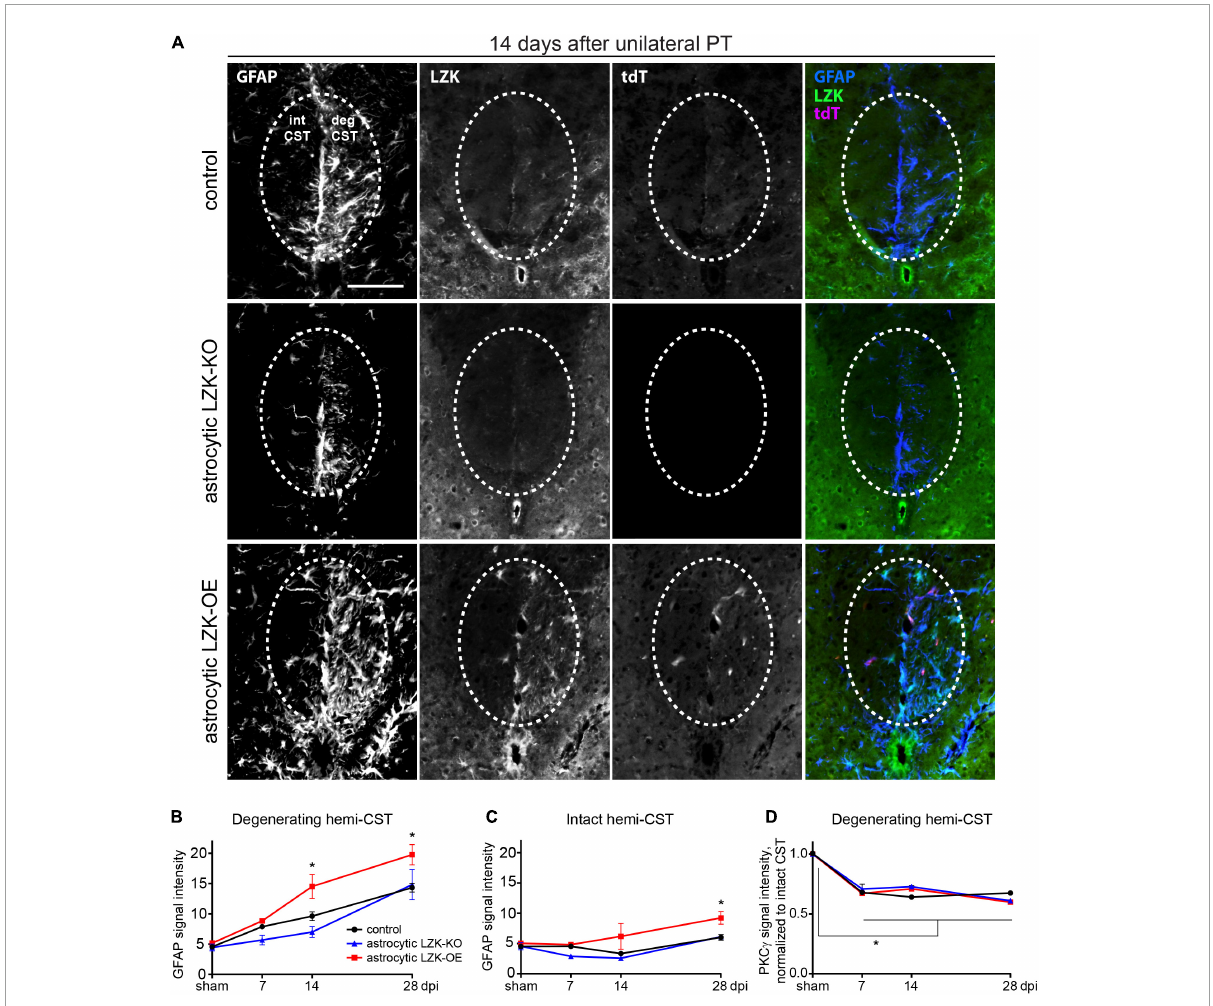
FIGURE2 LZK is a positive regulator of astrocyte reactivity to CST axon degeneration. (A) Immunofluorescence staining of LZK and GFAP in the CST at the cervical spinal cords of tamoxifen treated genotype control, astrocytic LZK-KO (GFAP-CreER T2 ; LZK f / f ), and astrocytic LZK-OE (GFAP-CreER T2 ; LZK OE ) mice; 14 days after unilateral PT. Dotted ovals outline the CST; intact and degenerating (deg) hemi-CSTs are indicated in the upper left panel that applies to all images; scale bar represents 100 µ m. (B) Quantification of astrocyte reactivity within the degenerating hemi-CST, based on GFAP immunofluorescence intensity, in tamoxifen treated genotype control, astrocytic LZK-KO (GFAP-CreER T2 ; LZK f / f ), and astrocytic LZK-OE (GFAP-CreER T2 ; LZK OE ) mice without injury and on 7, 14, and 28 days after unilateral PT. n = 3 per genotype per timepoint; graphing group mean with SEM. By two-way ANOVA, p < 0.05 for main injury effect and genotype effect, no interaction. Asterisk (*) on graph indicates p < 0.05 for post-hoc comparison between genotype control and GFAP-CreER T2 ; LZK OE mice at the corresponding timepoints with Bonferroni correction. Not marked on graph: p < 0.05 for the following post-hoc comparisons of injury effect within each genotype with Bonferroni correction (control—sham vs 14 dpi or 28 dpi; astrocytic LZK-KO—sham vs 28 dpi; astrocytic LZK-OE—sham vs 14 dpi or 28 dpi). (C) Quantification of astrocyte reactivity within the intact hemi-CST, based on GFAP immunofluorescence intensity, in the indicated tamoxifen treated groups over a time course after unilateral PT. n = 3 per genotype per timepoint; graphing group mean with SEM. By two-way ANOVA, p < 0.05 for main injury effect and genotype effect, no interaction. Asterisk (*) on graph indicates p < 0.05 for post-hoc comparison between genotype control and GFAP-CreER T2 ; LZK OE mice at the corresponding timepoint with Bonferroni correction. Not marked on graph: p < 0.05 between sham vs 28 dpi within LZK-OE group, by post-hoc comparison with Bonferroni correction. (D) Quantification of CST axon degeneration within the degenerating hemi-CST, based on PKC γ immunofluorescence intensity, in the indicated tamoxifen treated groups over a time course after unilateral PT. n = 3 per genotype per timepoint; graphing group mean with SEM. By two-way ANOVA, p < 0.05 for injury effect only. Asterisk (*) on graph indicates p < 0.05 for post-hoc comparison in PKC γ signal intensity between sham injury and all post-injury timepoints with Bonferroni